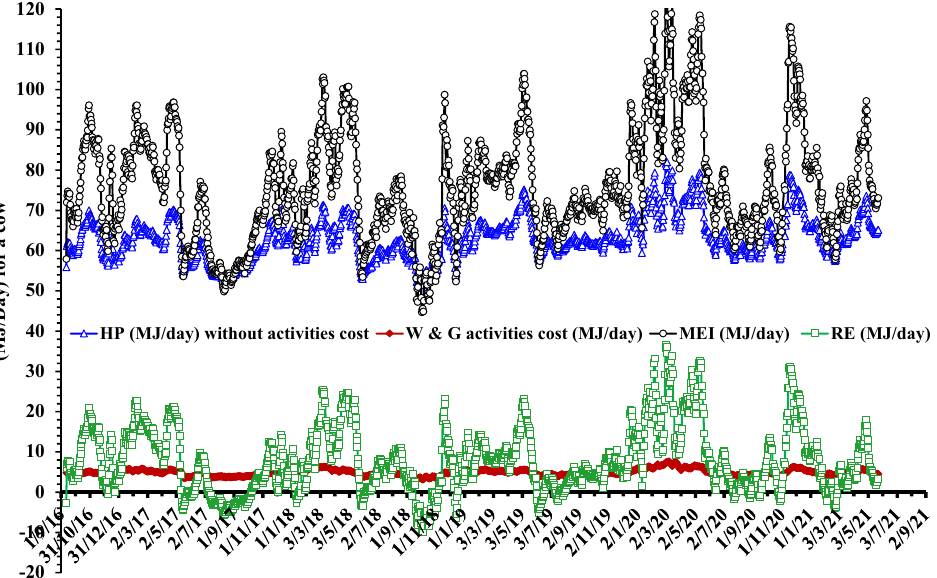
Figure 6. Studied cows’ energy balance variables (MJ/day) as calculated by the HMS. Metabolizable energy intake (MEI, o), heat production (HP, ∆ ), energy cost of walking (W) and grazing (G) activities (activity cost, ♦ ) and recovered energy (RE, □ ). Dates are given as day/month/year.